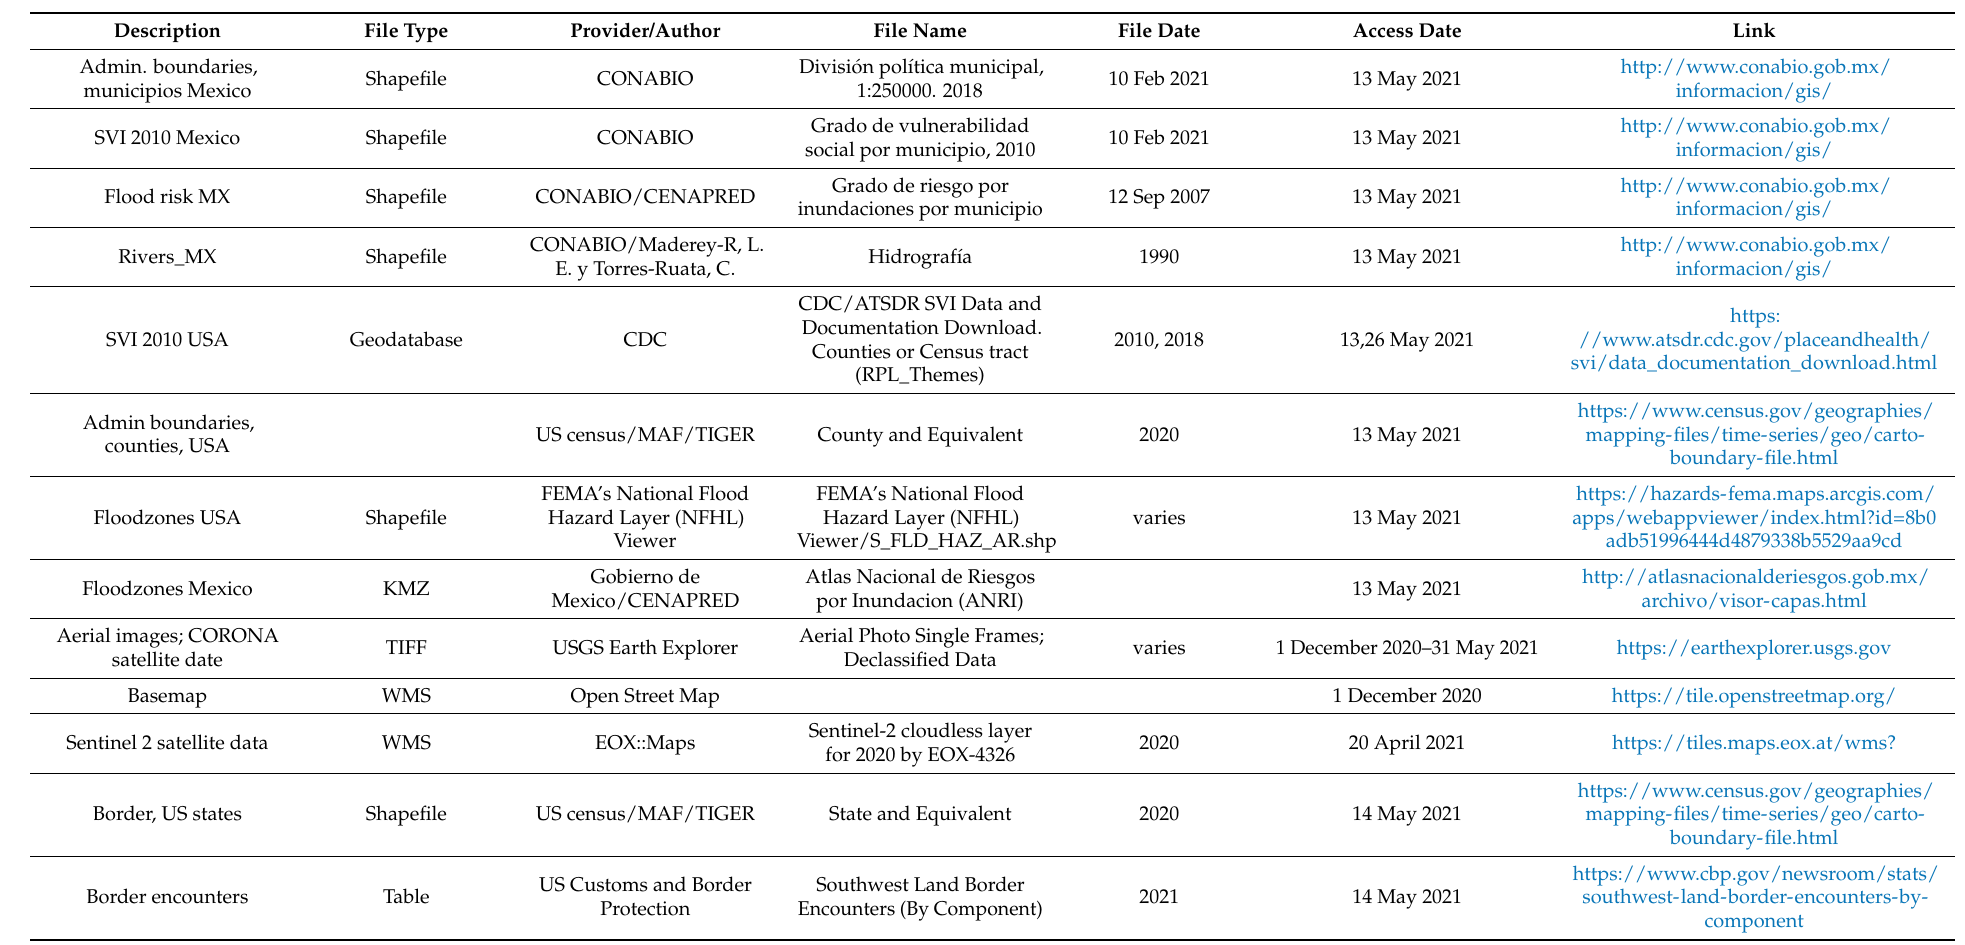
Table A2. List of data